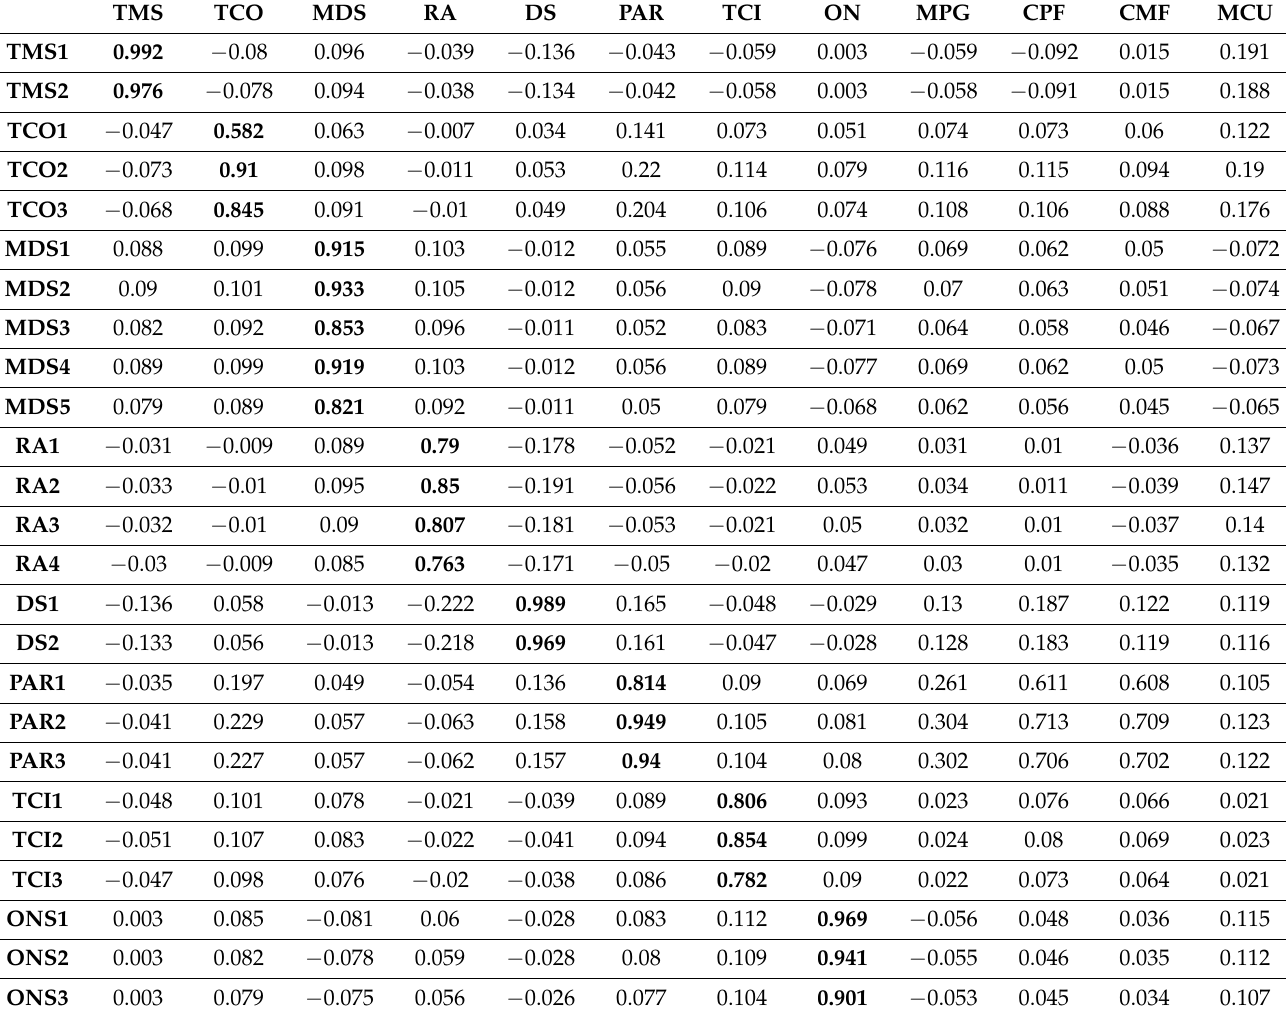
Table A4. Correlation matrix for observed